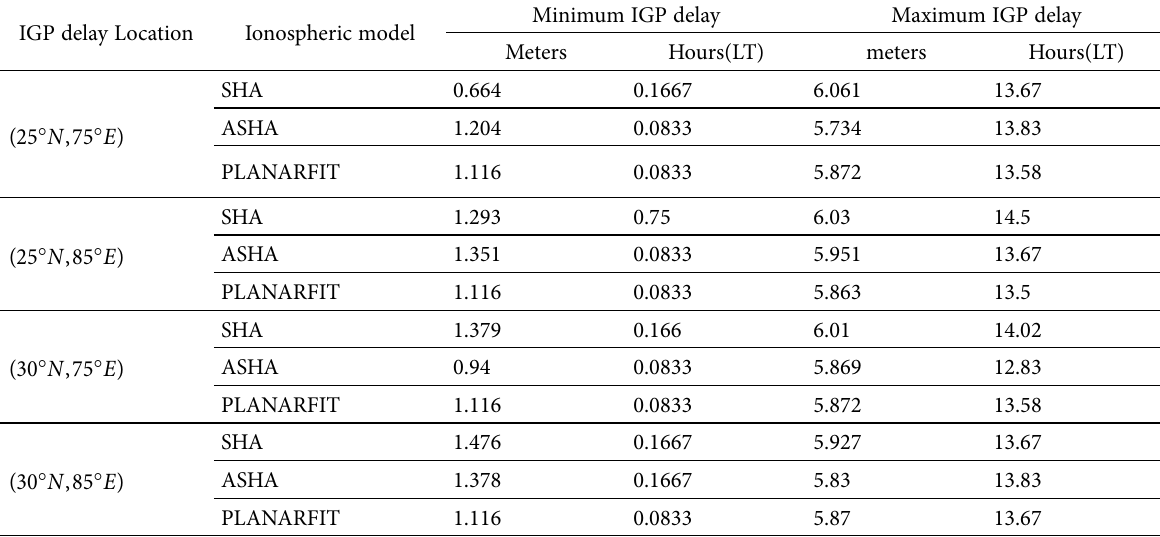
Table 1. IGP delays observed at various IGP locations during the quiet day (July 05, 2004) IGP delay